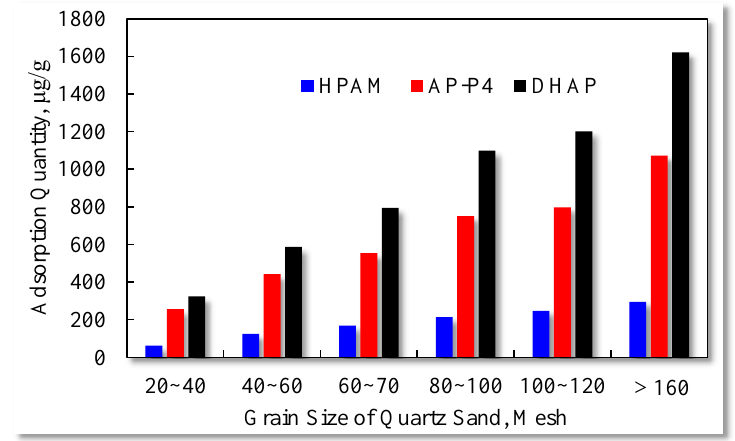
Figure 12. Effect of quartz sand particle size on polymer adsorption capacity. The static adsorption of the three polymers increases with the increase in the quartz sand particle size. The results confirm that the total surface area of the quartz sand particles (with identical quality) increases with particle size reduction. More adsorption surfaces are accessible to the polymers, and the multilayer adsorption characteristics expand, raising the adsorption quantity.